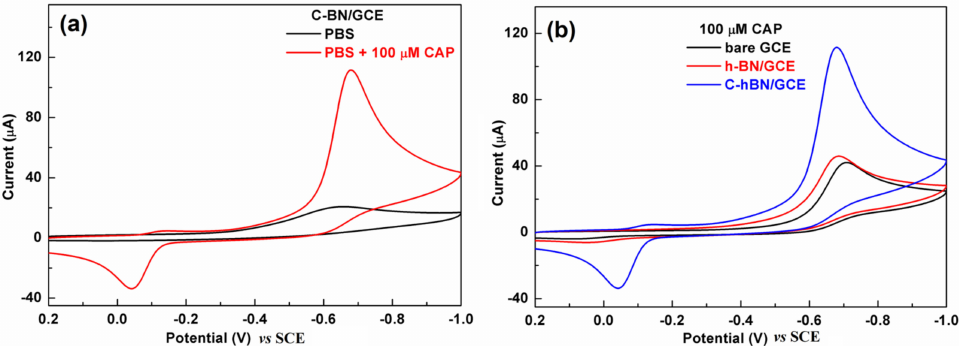
Figure 5. ( a ) CVs of C-BN/GCE in the absence/presence of 100 µ M CAP; ( b ) CVs of GCE, h -BN/GCE and C-BN/GCE in the presence of 100 µ M CAP. (Conditions: 0.2 M PBS with pH of 7.0 at a scan rate of 100